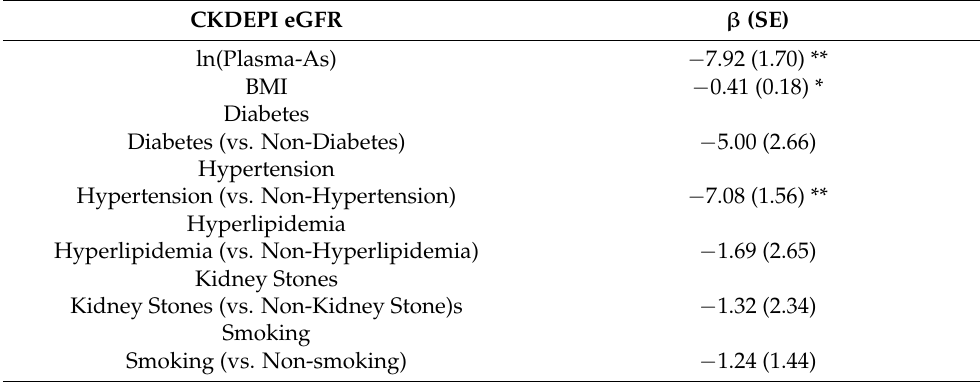
Table 3. Multiple regression of plasma As on CKDEPI eGFR without